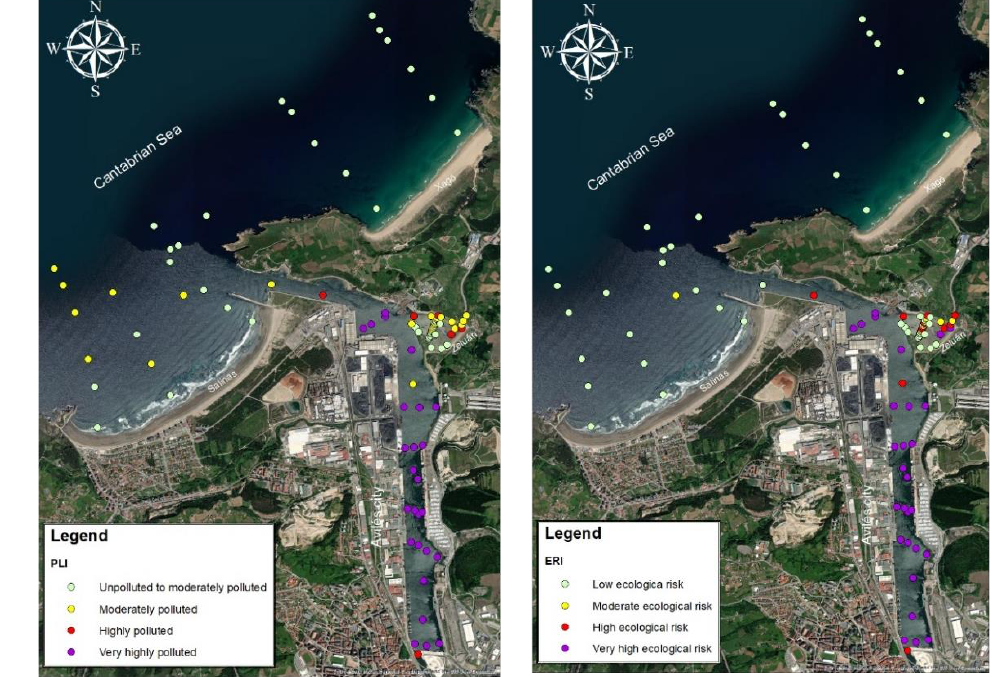
Figure 5. Geographical representation of the pollution load index (PLI) and environmental risk index Values (ERI) classified according to [18] criteria.